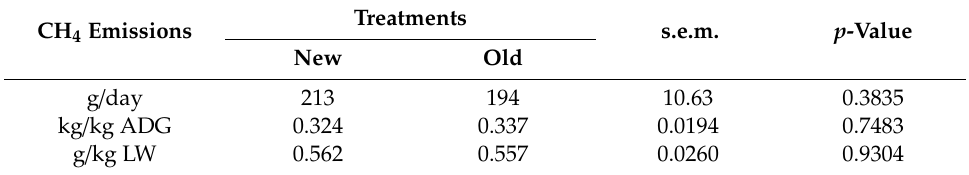
Table 4. Methane emission factors of Canchim steers from di ff erent lines reared on pasture.